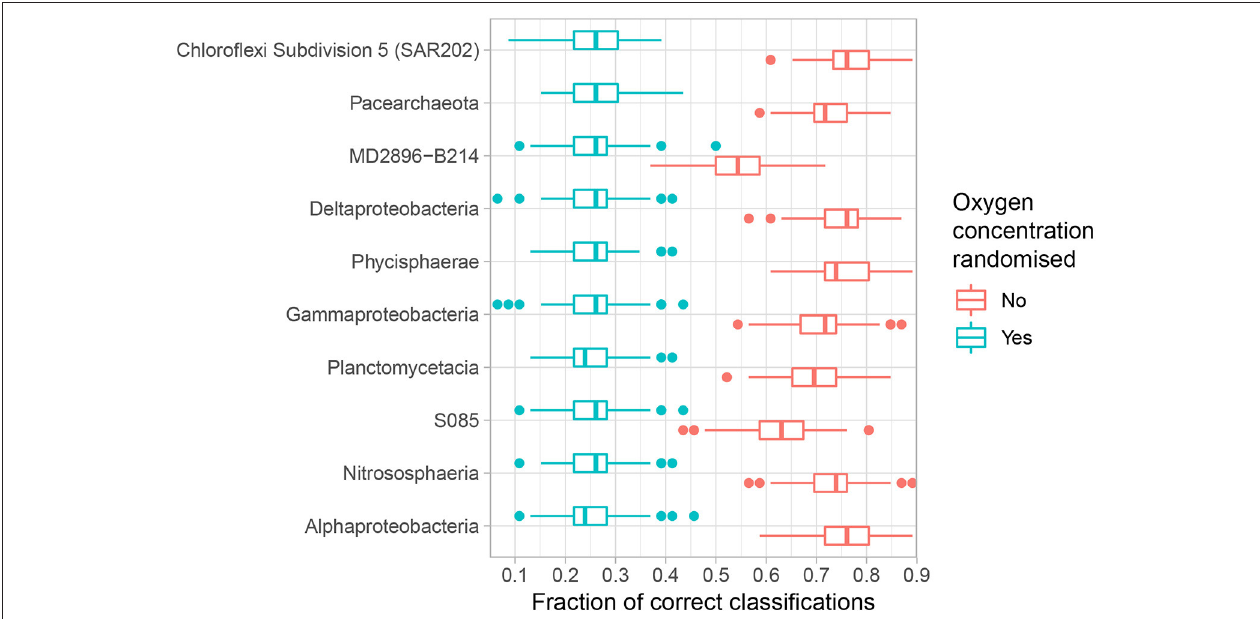
FIGURE 3 | Accuracy of the top 10 abundant classes in quaternary classification analysis ( Table 1 ). Analyses were repeated n = 128 times. Boxes denote the 25–75 percentiles, whiskers roughly the 95% confidence interval ( Wickham, 2011). Blue boxes denote results where the dependent variable has been shuffled to signify results expected by random chance, red boxes with no randomisation. Relative abundance decreases